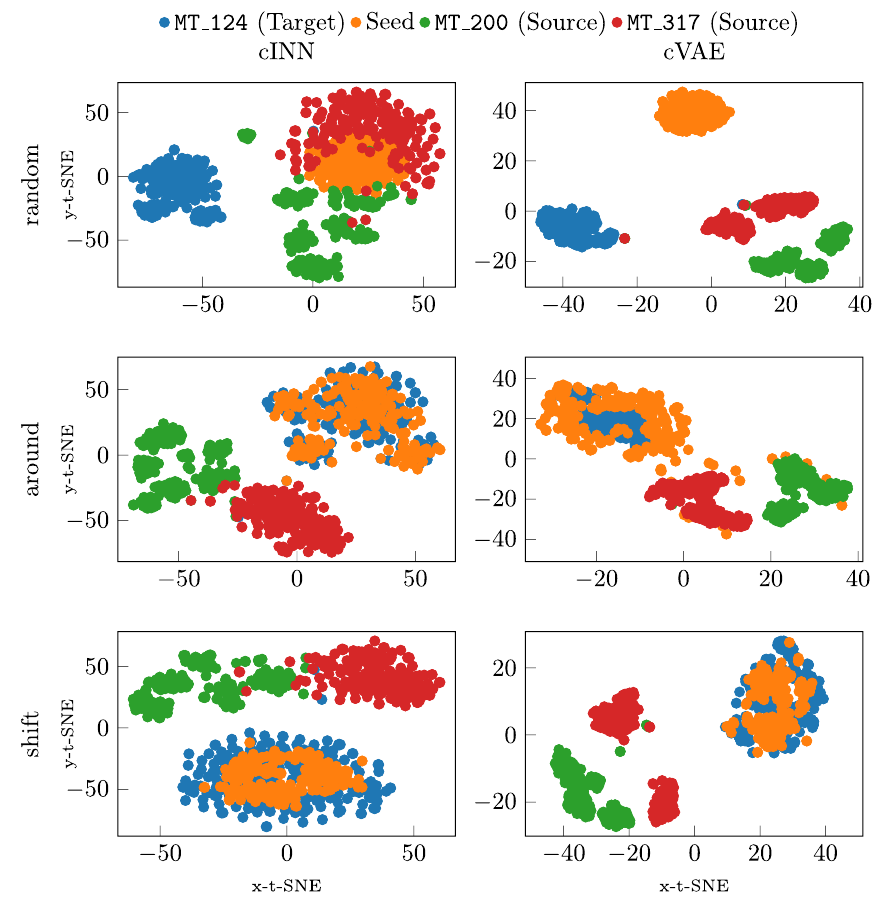
Fig. 4 The t-SNE visualisations of the latent space representation of 300 randomly selected samples from the target data ( MT_124 ), the seed noise r seed , and the source data ( MT_200 and MT_317 ) for the three seed noise sampling strategies (random, around, and shift) and the two generative models (cINN and cVAE). Note that the different subfigures can only be compared qualitatively due to randomly selected start values and different input